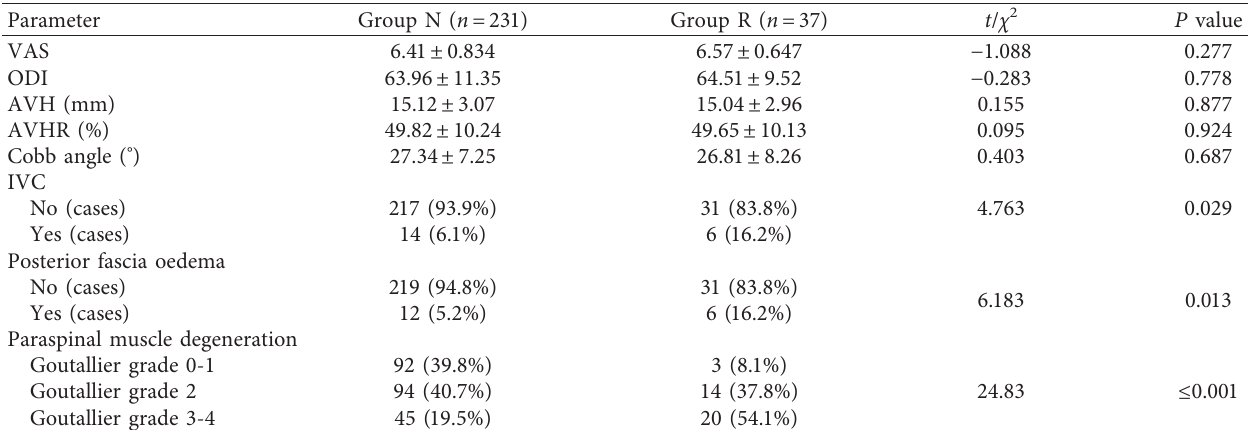
Table 3: Comparisons of VAS 、 ODI, and preoperative radiological parameters between patients between group N and group R.